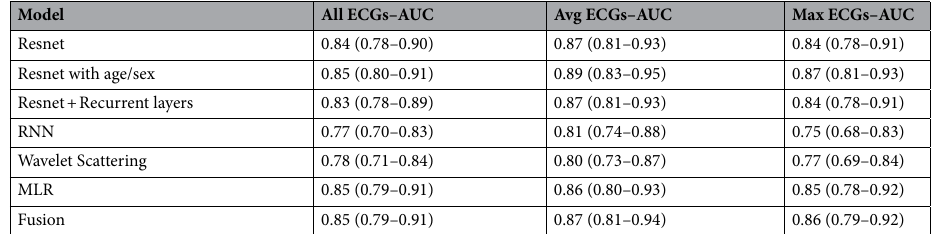
Table 1. Comparison of AUC results achieved for different models, according to different aggregation rules. The performance of six different models is evaluated with AUC. AUC for the Fusion model is computed by averaging for each ECG sample the six AF scores computed by the different models. The same data have been used to train and evaluate the six models. The only exception refers to MLR and Fusion models, where ECG samples with missing discrete values have been discarded from the analysis. AUC results are computed according to three different aggregation rules: i) no aggregation (All ECGs), ii) average of AF scores related to the same patient (Avg ECGs), and iii) selection of the highest AF score for each patient (Max ECGs). 95% confidence intervals are reported in brackets. ECG Electrocardiogram, AUC Area Under the Curve, RNN Recurrent Neural Network, MLR Multivariate Logistic